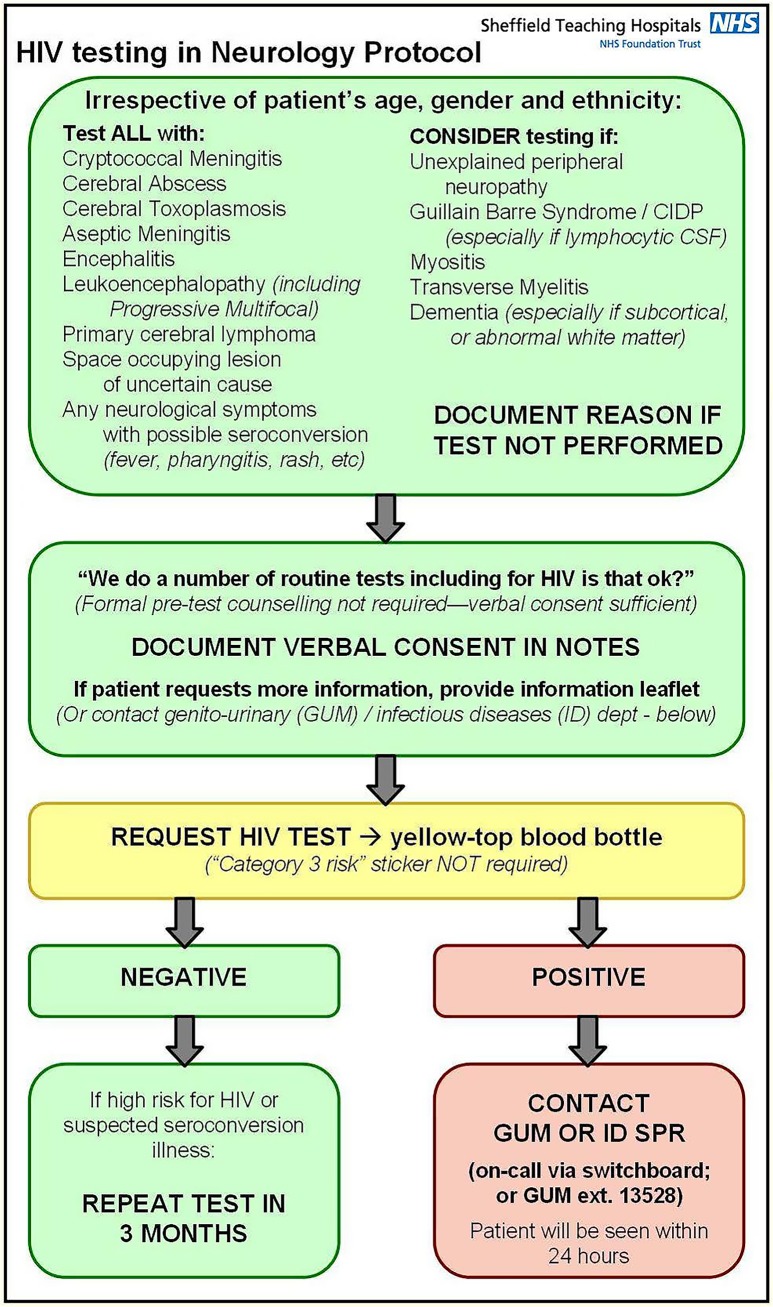
The Sheffield “HIV Testing in Neurology” protocol.Based on the UKNG Guidelines for HIV testing. We have previously presented preliminary data from an audit of the effectiveness of this protocol alone in improving HIV testing [32]. We evaluated efficacy of improving HIV testing in eligible patients by re-auditing our service after changing the neurology admission proforma and introduced training sessions. We also studied the total number of HIV tests sent from the acute neurology unit.